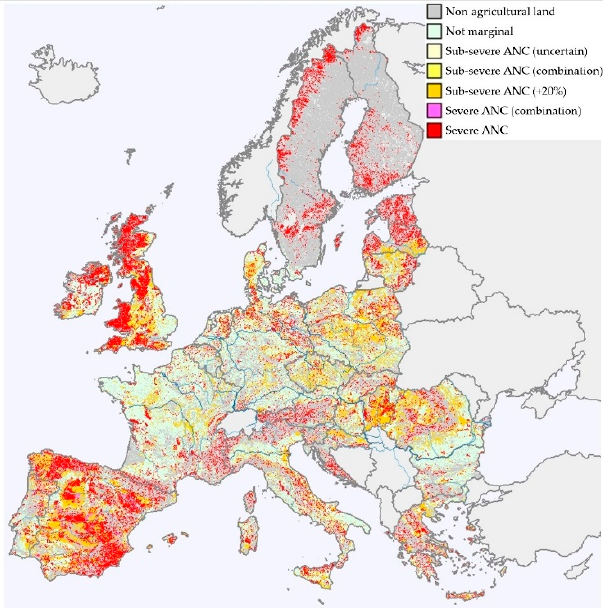
Figure 5 Figure 4. Current distribution of marginal agricultural land (ANC: agricultural natural constraint. Sub-severe ANC + 20% is within the 20% margin of the threshold value of severity) in Europe (adapted from